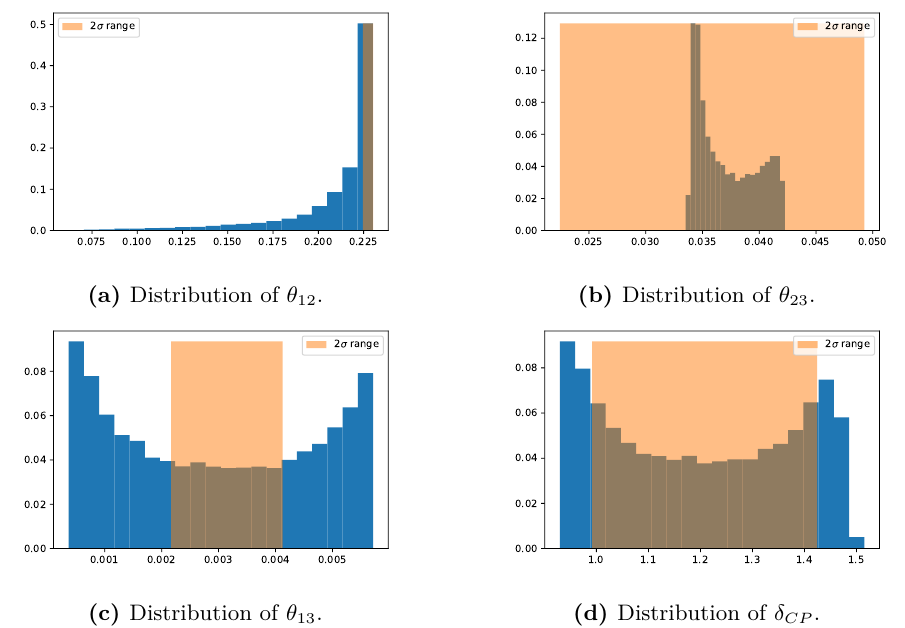
Figure 1. Distribution of the mixing angles and CP-phase. The blue bars denote the distributions of the mixing angles and the CP-phase. The distributions have been normalized already. The orange regions denote the 2 σ ranges of the corresponding